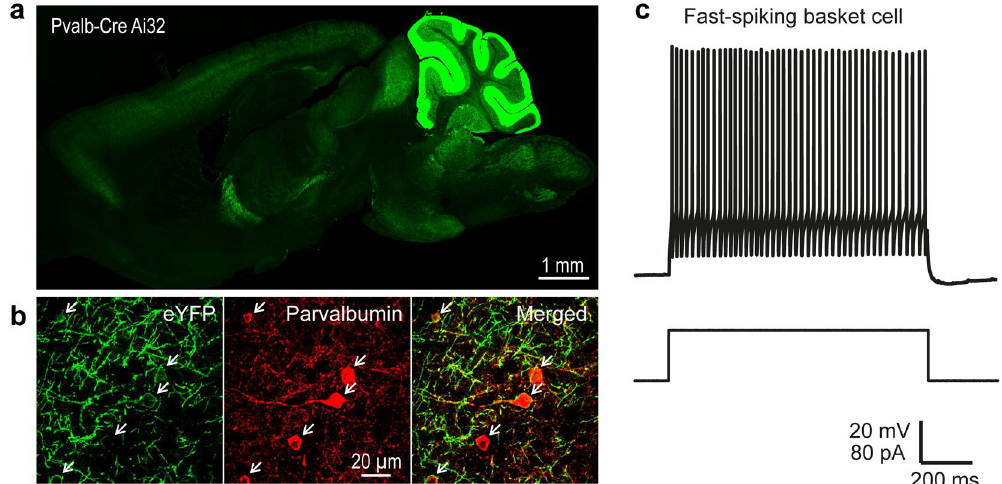
Figure 1. Expression of eYFP-tagged ChR2 in PV interneurons in the somatosensory cortex. ( a ) Expression of eYFP-tagged ChR2 (in green) in the cortex and cerebellum of double-transgenic Prv-Cre x Ai32 mice. ( b ) eYFP-tagged ChR2 (green) is expressed in PV interneurons (red) in the somatosensory cortex. ( c ) Action potential firing pattern (top trace) elicited in a fast-spiking basket cell in response to a 1 s duration depolarizing current pulse (lower